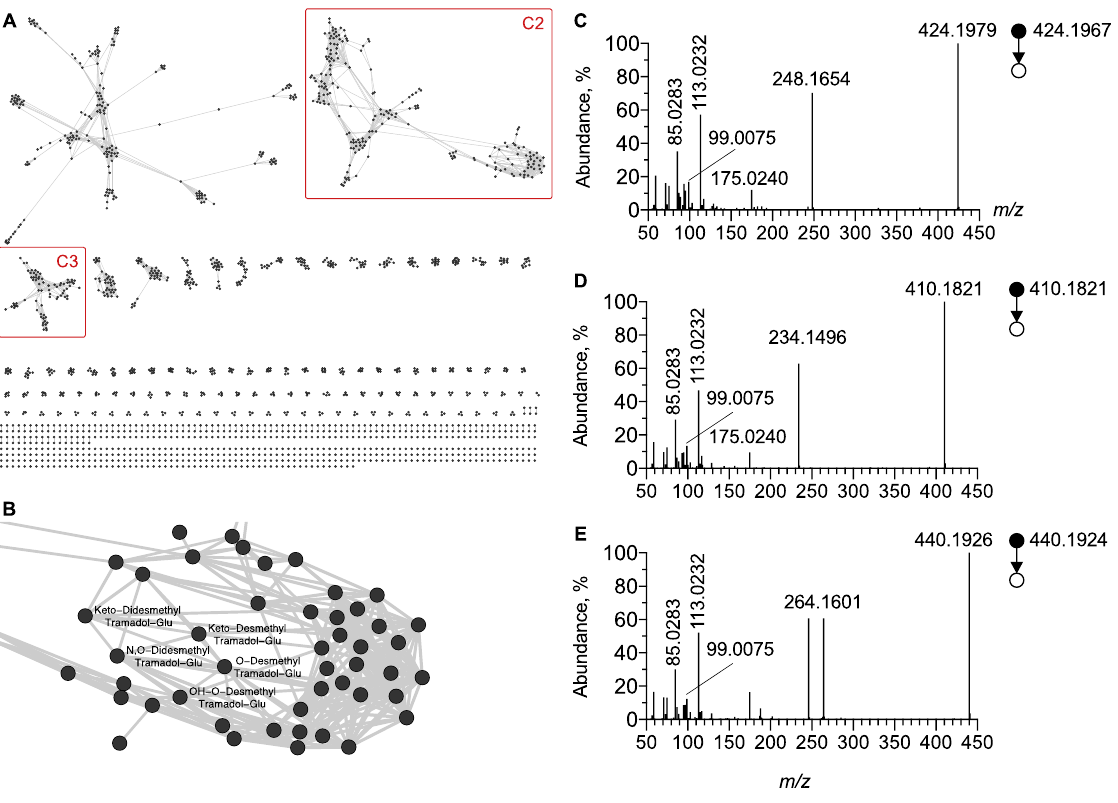
Figure 6. Molecular network generated under negative ion mode. ( A ) Global overview and ( B ) focus on the C2 cluster of glucurono-conjugated molecules including tramadol. MS/MS spectra of [M-H] - ion corresponding to ( C ) O-desmethyl tramadol glucuronide, ( D ) N,O-didesmethyl tra- madol glucuronide and ( E ) OH-O-desmethyl tramadol glucuronide, respectively. Note that uniden- tified nodes correspond to glucurono-conjugated endogenous metabolites. Similarly, a third cluster ( C3 ), part of the MN generated in negative ion mode, was attributed to sulfo-conjugated molecules (Figures 6A and 7A). The [M-H] - ion of O - desmethyl tramadol sulfate was detected at t R = 3.83 min and m / z 328.1207 (Δppm = 1.8) and its MS/MS spectra displayed a peak at m/z 248.1653 (Δppm = 1.8). This resulted from the neutral loss of 79.9568 Th corresponding to the sulfate radical (Figure 7B). The MS/MS spectra also displayed a peak at m / z 79.9561 corresponding to the dioxosulfanolate ion, characteristic of the sulfate radical. Using the same approach, three additional sulfo-con- jugated tramadol metabolites were identified from the cluster C3, including O-desmethyl tramadol sulfate (M20), N,O-desmethyl tramadol sulfate (M22), and N,N,O-desmethyl tramadol sulfate (M21) (Figure 7B – D).